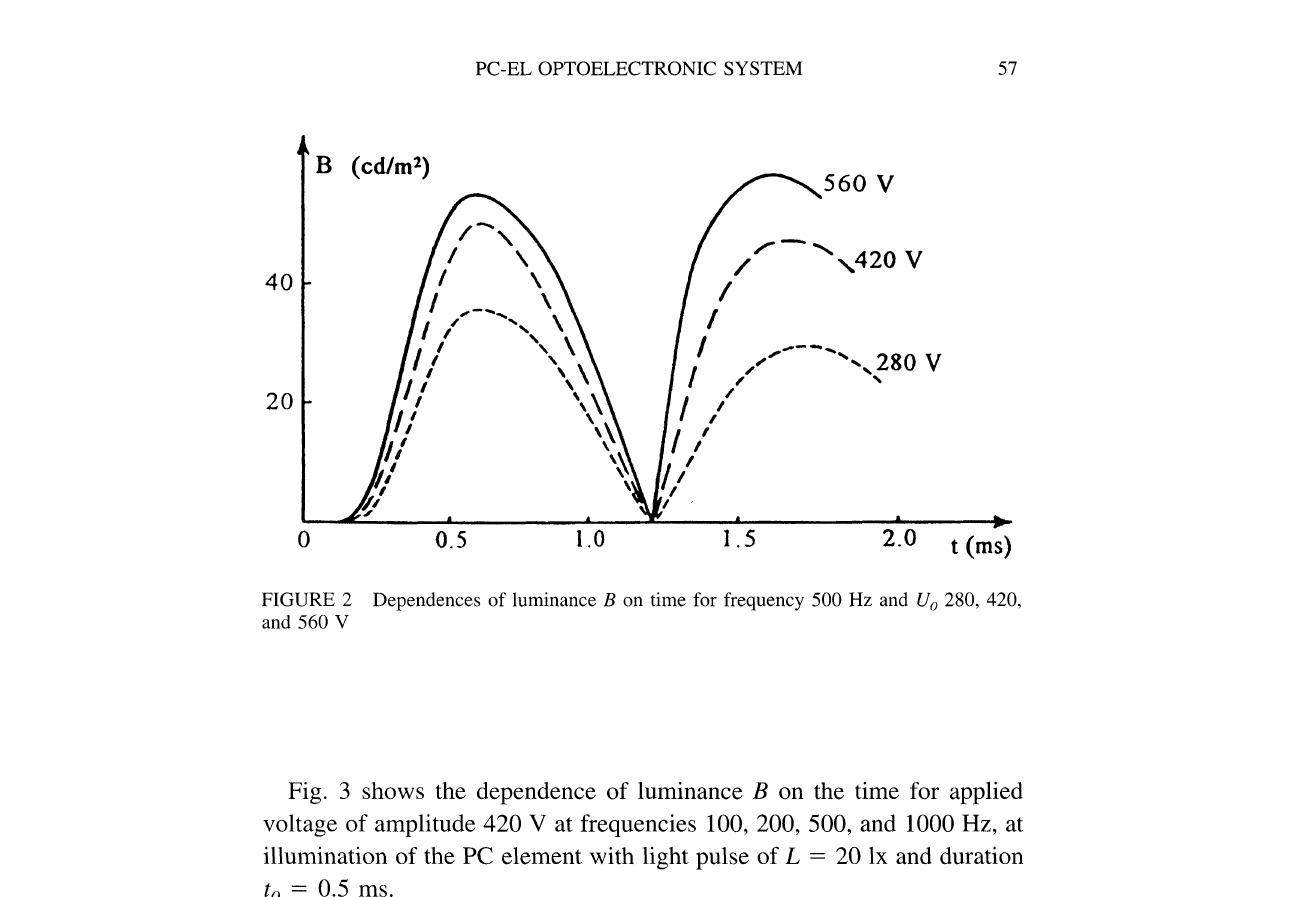
FIGURE 2 Dependences of luminance B on time for frequency 500 Hz and Uo 280, 420, and 560